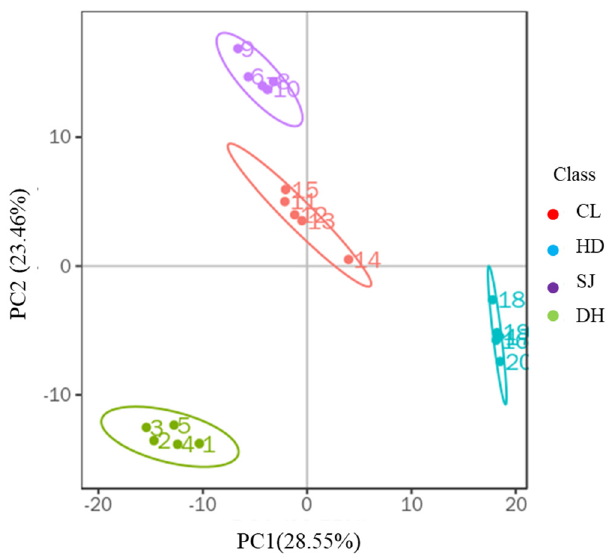
Figure 1. Three ‐ dimensional diagram of PCA of four rice samples (Daohuaxiang (DH), Huaidao No. 5 (HD), Songjing (SJ), and Changlixiang (CL)). No. 5 (HD), Songjing (SJ), and Changlixiang